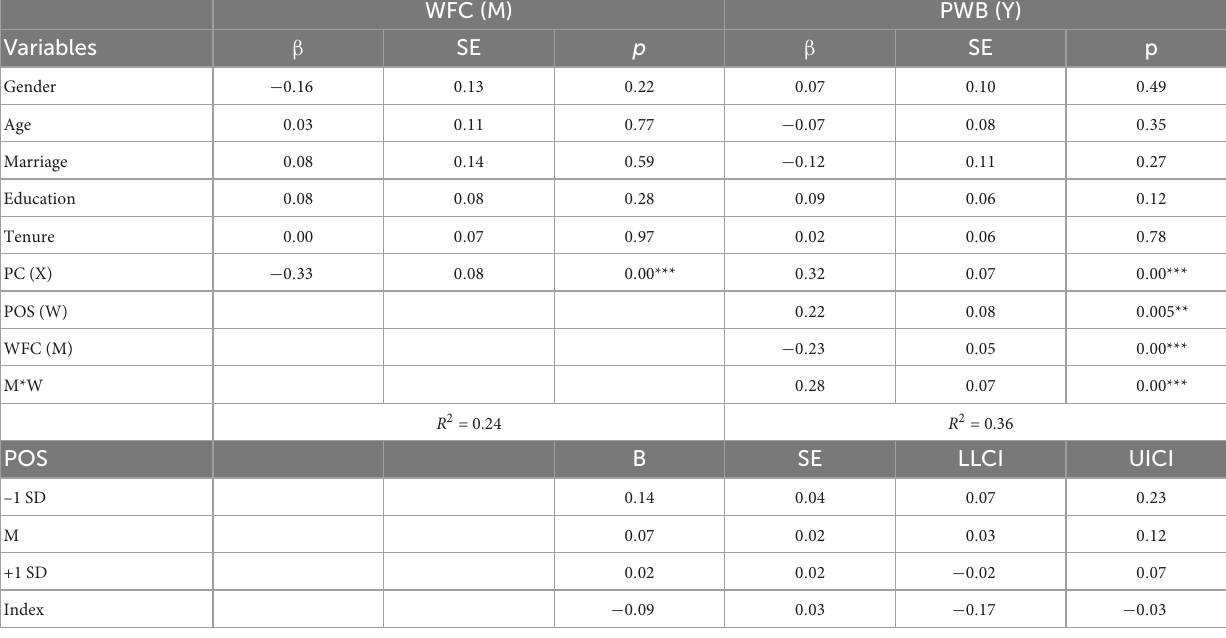
TABLE 5 Results of moderated-mediation of WFC.